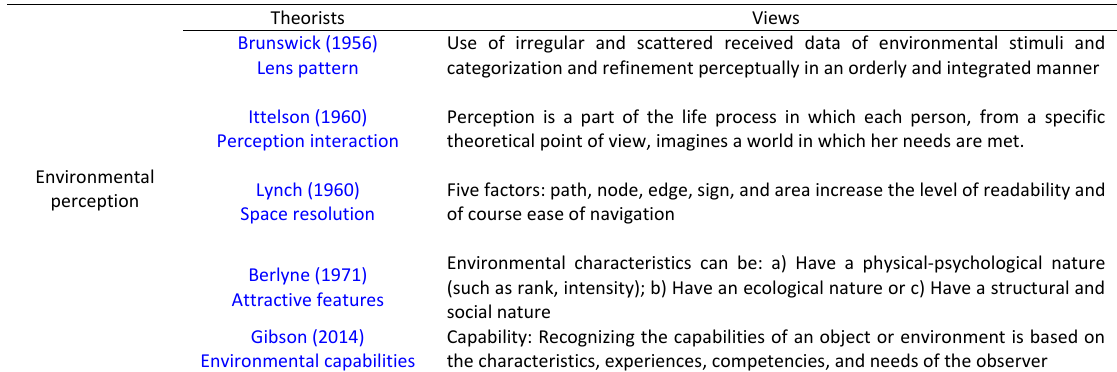
Table 2: Environmental perception theories